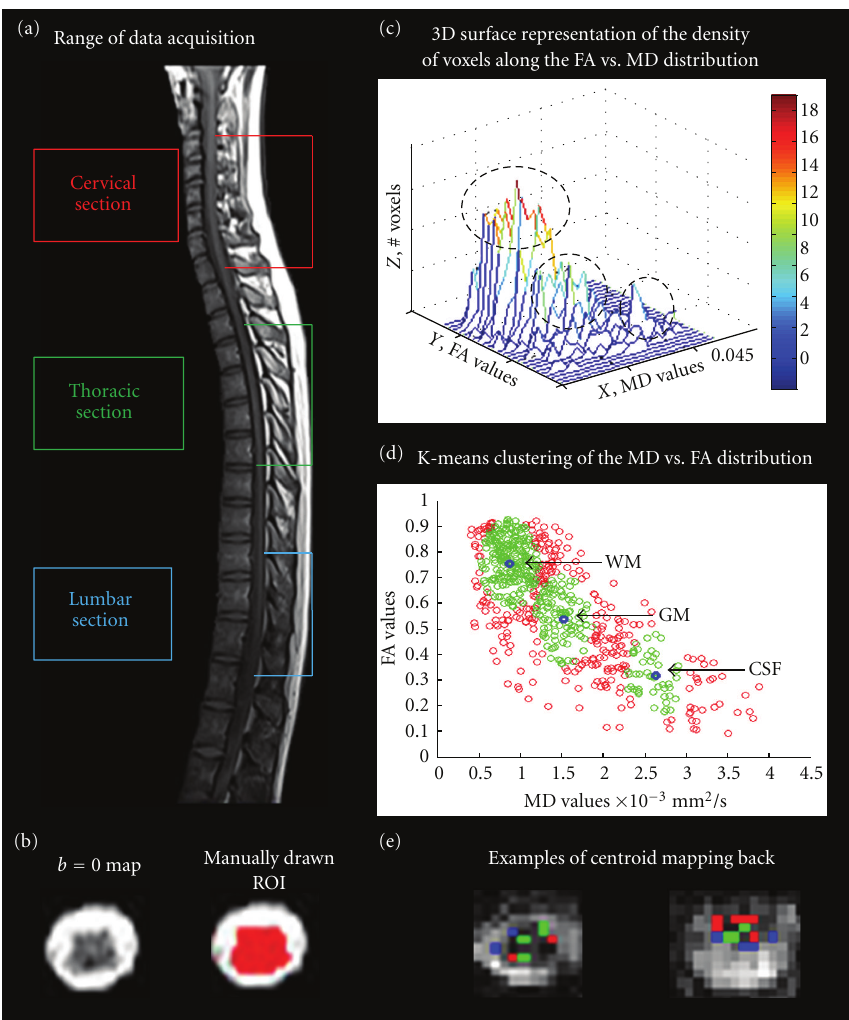
Figure 1: (a) Sagittal view of the spinal cord indicating the cervical, thoracic, and lumbar regions acquired in the di ff usion-weighted data. (b) An example of a b = 0 map and the same b = 0 map with an ROI manually drawn on the image to indicate the boundaries of the spinal cord. (c) An example of a 3D-surface representation of the density of voxels along the FA versus MD distribution from the cervical cord of one subject. The height of the surface ( z ) reflects the number of voxels with overlapping MD ( x ) and FA ( y ) values on the plot. From this example, it is apparent that voxels cluster in three distinct groups, the highest density of voxels with high FA and low MD values, the middle cluster with low FA and low MD values, and a small third cluster with low FA and high MD values. (d) An example of the FA versus MD voxel distribution in the cord from one subject in the cervical region of the spinal cord. All voxels were plotted (red) and a k-means clustering method partitioned the data into three distinct clusters. The center of the cluster (or “centroid”) is shown in blue and is the mean FA and MD of each cluster. Clusters were further restricted to include only voxels which fell within a threshold distance from the centroid (green), thereby, excluding the voxels with the greatest amount of partial volume e ff ects. Clusters with high FA values and low MD values are assigned to white matter (WM), clusters with low FA values and low MD values are assigned to grey matter (GM), and clusters with low FA values and very high MD values are assigned to cerebral spinal fluid (CSF) and noise. (e) Two examples of the spatial location of the centroid mapping back. The green voxels indicate where the grey matter cluster mapped back to, while the red indicates white matter voxels and the blue is CSF. Grey matter voxels (green) were located in the center regions of the cord and extended outwards towards the dorsal and ventral horns while white matter clusters (red) were located to areas outside of the grey matter regions. CSF clusters (blue) consistently mapped to the outer boundaries of the